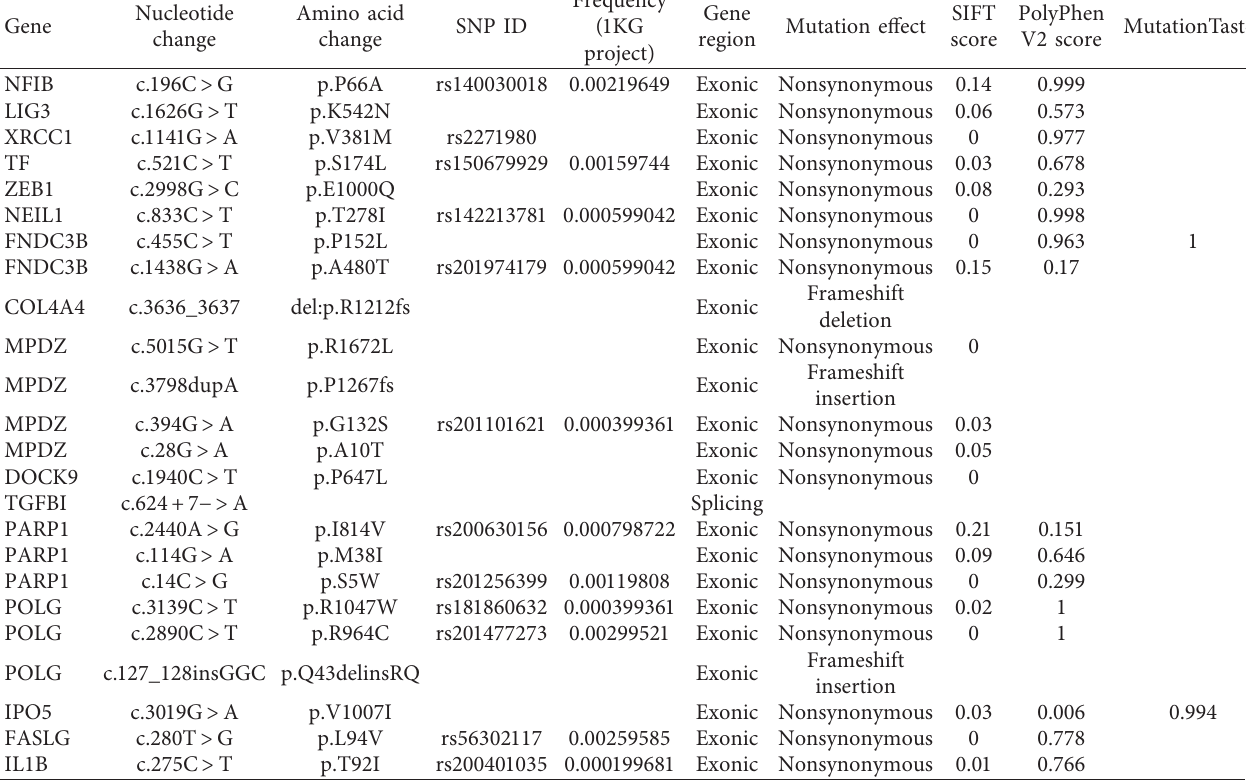
Table 1: All variants identified in KC patients in the present study.